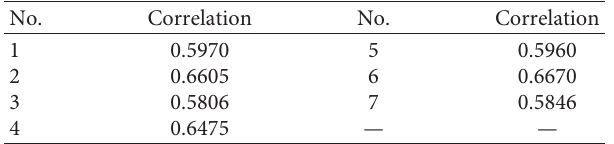
Table 3: Correlation between common peaks of saponins from Glycyrrhiza uralensis Fisch. and tail suspension test.